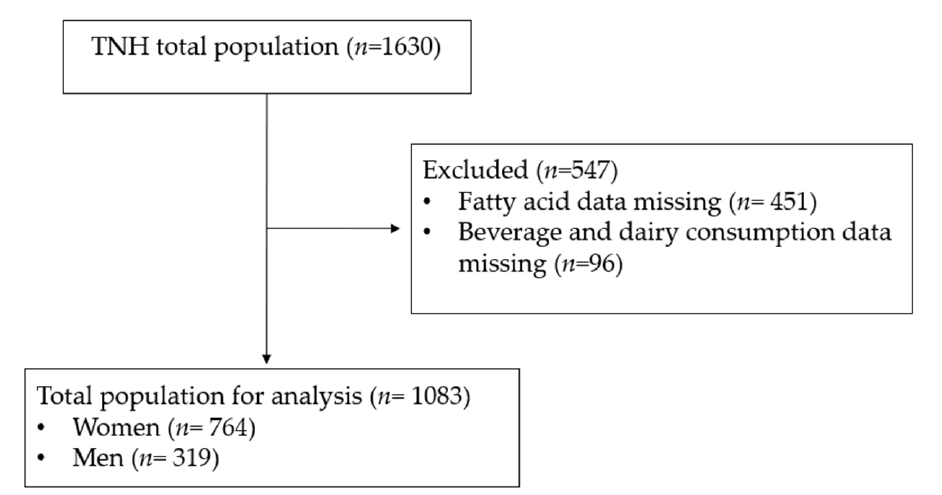
Figure 1. CONSORT diagram. Subject inclusion and exclusion criteria.